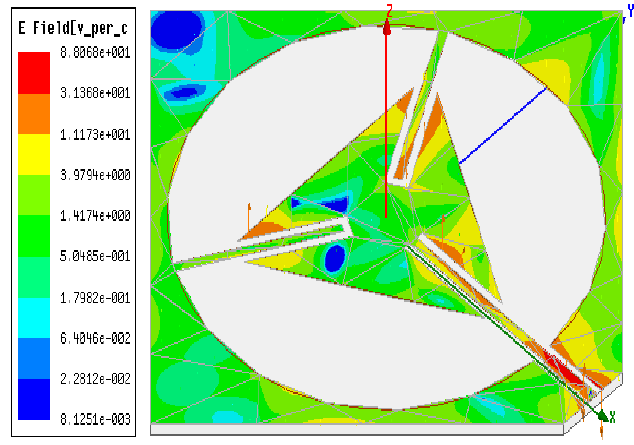
Figure 18. Distribution of E-field of Slot antenna 4 at 2450 MHz.